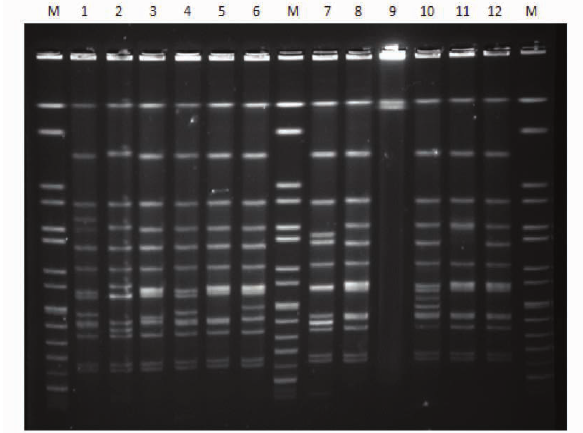
Figure 1: Pulsed field gel electrophoresis (PFGE) band images for samples from seven patient cases and five environmental samples.